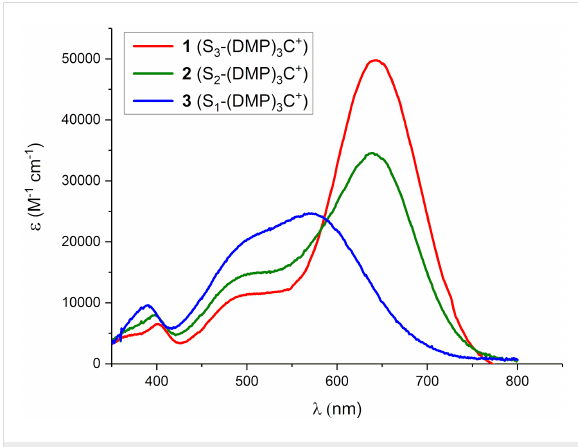
Figure 3: UV–vis spectra in MeCN: S 3 -(DMP) 3 C + ( 1 , red), S 2 -(DMP) 3 C + ( 2 , green), and S 1 -(DMP) 3 C + ( 3 , blue).